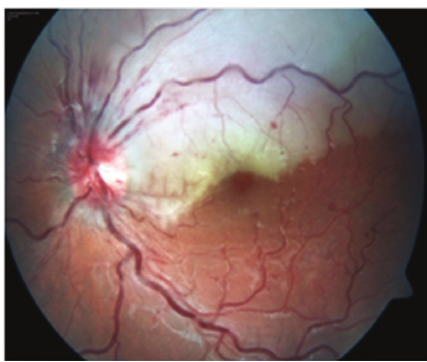
Figure 1: Retinal edema with occasional hemorrhages in the upper temporal quadrant of the left